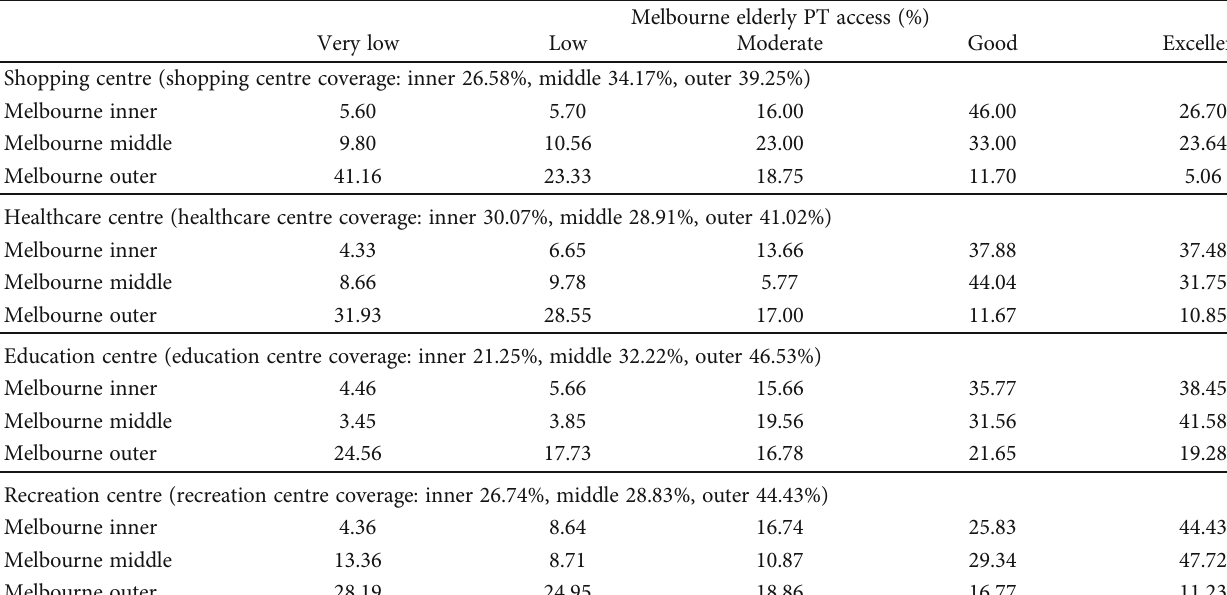
Table 9: Summary of elderly PT accessibility